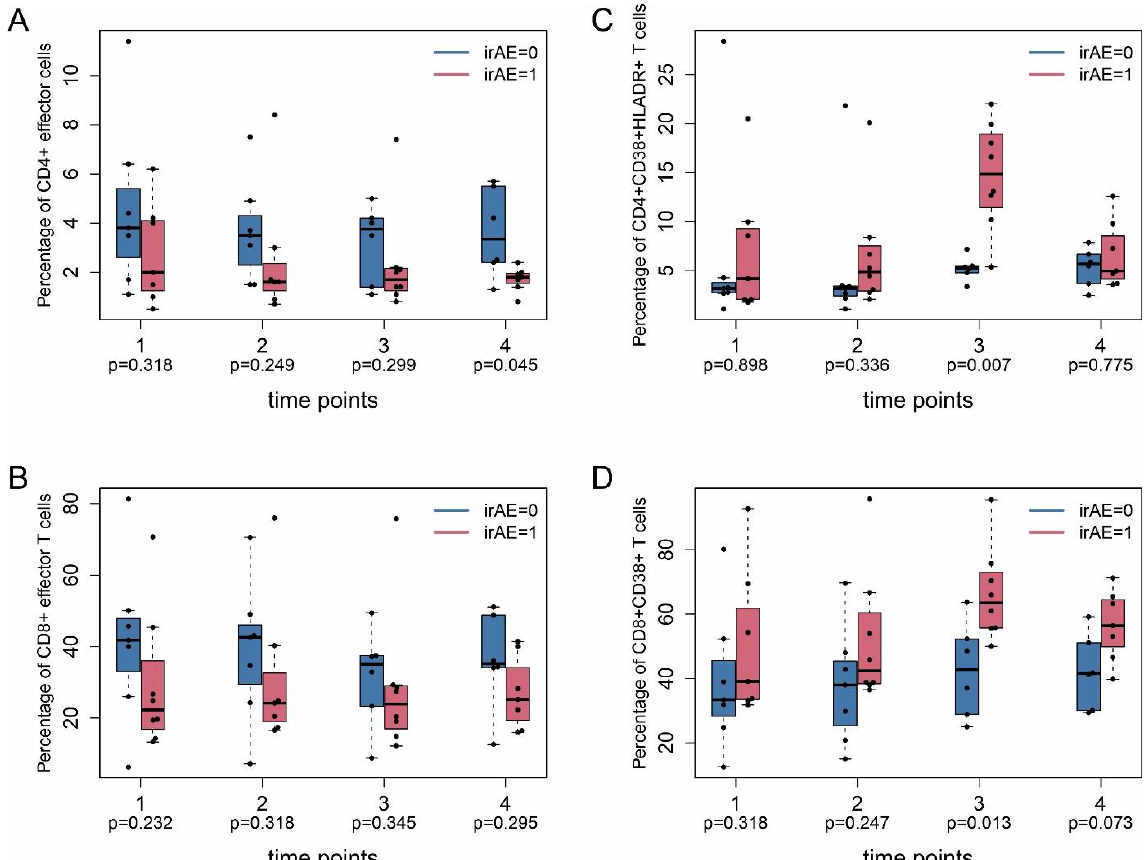
Figure 4. Inflammatory T cell subpopulations in patients with and without irAE. PBMC were taken from patients at indicated time points as described in Figure 1 and analyzed by flow cytometry (FACS). ( A , B ) Percentage of CD4 + and CD8 + effector T cells. ( C ) CD4 + CD38 + HLADR + T cells. ( D ) CD8 + CD38 + T cells. irAE, immune-related adverse events. 0, without; 1, with adverse events. Nominal (unadjusted) p -values (Mann–Whitney U test between irAE = 1 and irAE = 0) are shown without adjustment for multiple testing. Data in ( A , B ) are given as percentage of CD4 + effector cells and CD8 + effector cells, respectively, of total CD4 + and CD8 + cells. Data in ( C ) are given as percentage of CD38 + HLADR + cells of total CD4 + cells. Data in ( D ) are given as percentage of CD38 + cells of total CD8 + cells.